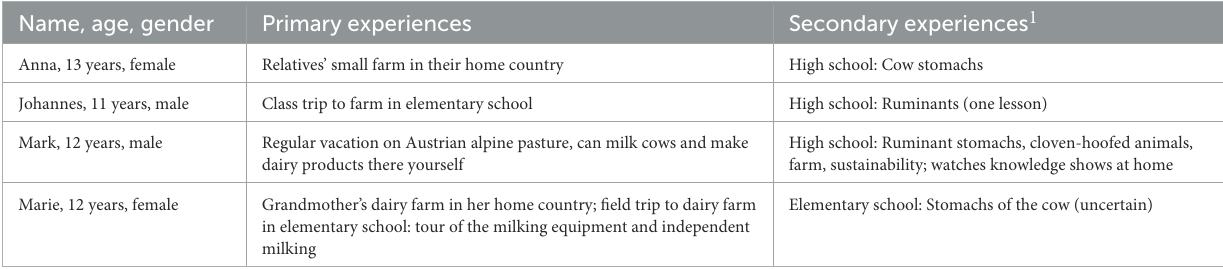
TABLE 1 Overview of sixth-grade students.